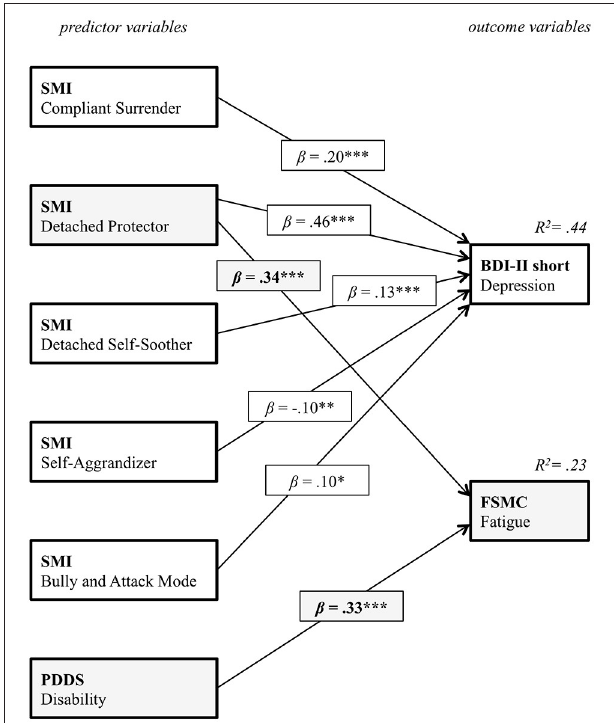
FIGURE 4 | Pathmodel for the relation between the five SMI maladaptive coping modes, the PwMS’ disability and the fatigue as well as depression symptoms.